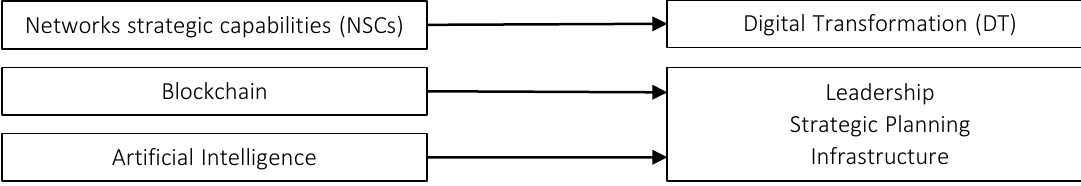
Figure 1. Conceptual